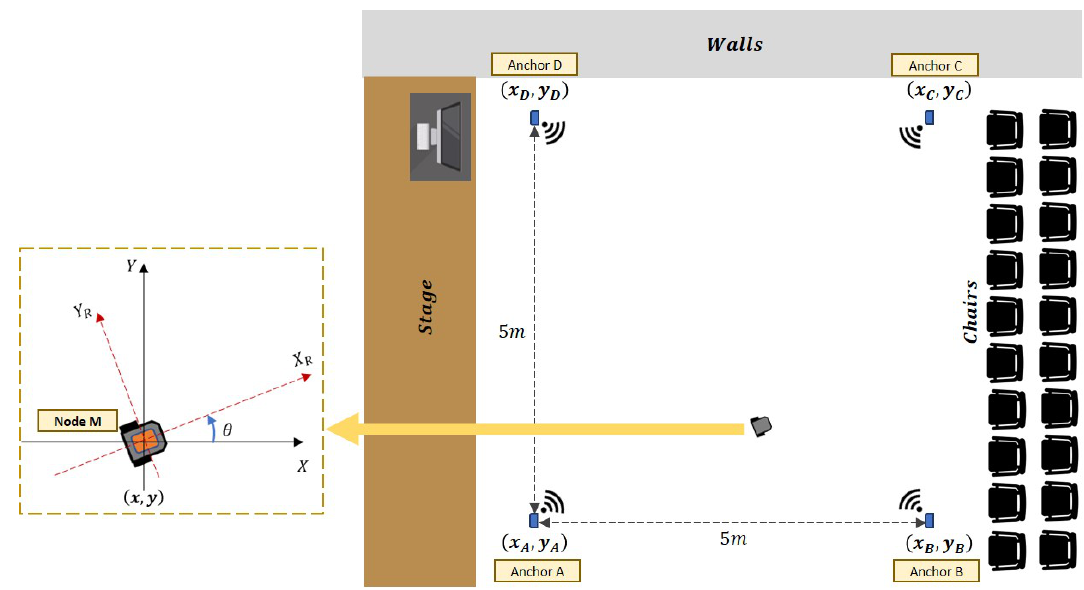
Figure 4. Illustration of the experimental setup from top view (not to